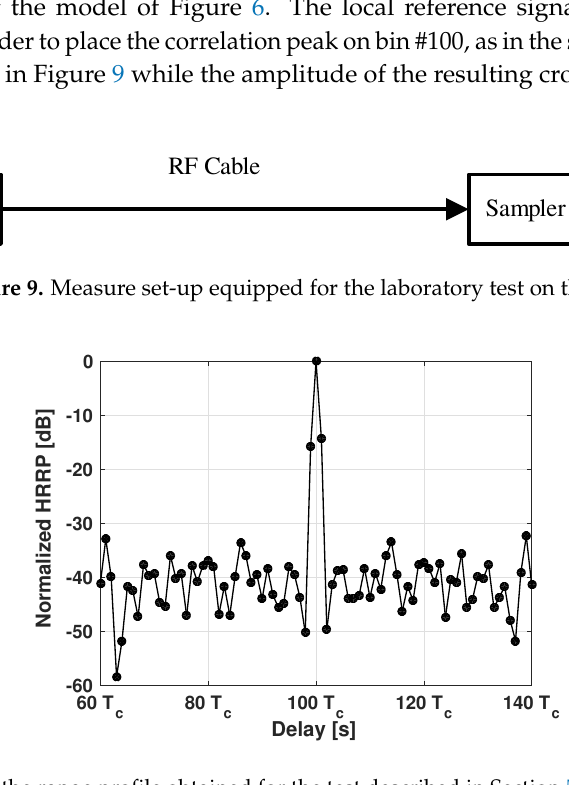
Figure 10. Detail of the range profile obtained for the test described in Section 5.1. It was normalized to the peak, placed at bin